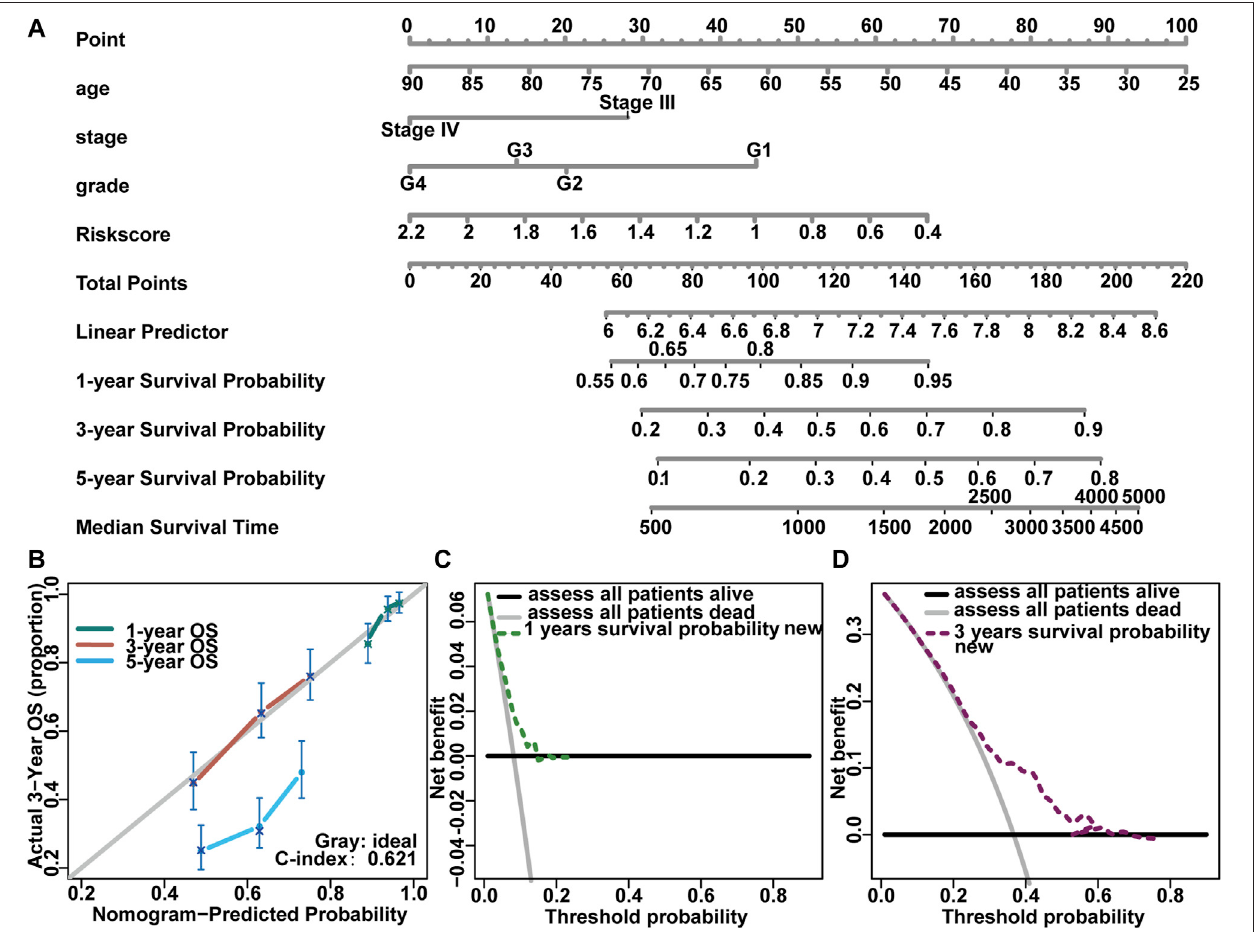
FIGURE 10| Construction of prognostic riskmodel and nomogram for genes with prognostic value. (A) The nomogram predicted overall survival in stage III-IV OV patients; (B) The calibration curves of nomogram evaluated OS showing the outcome of 1 year, 3 years, and 5 years; x -axis represented the nomogram prediction survival possibility, and y -axis represented the actual survival possibility; (C, D) Decision Curve Analysis evaluated the clinical utility of the nomogram. The x -axis represented the threshold possibility, and the y -axis represented the net benef.